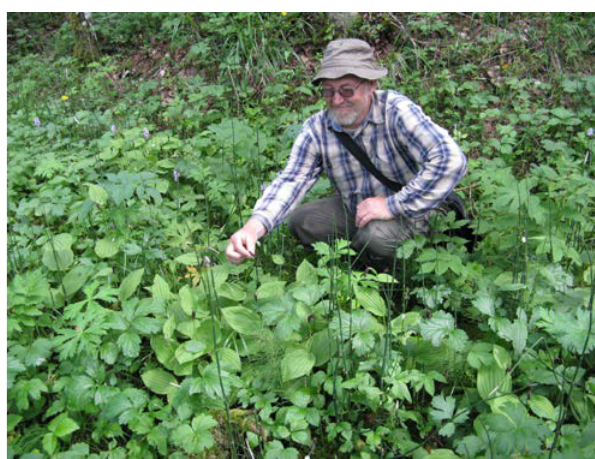
Figure 8. Tapio Lindholm in a flooded rich fen in mire in Mire 31 in 2008. Cicuta virosa is abundant (photo: Raimo Heikkilä).